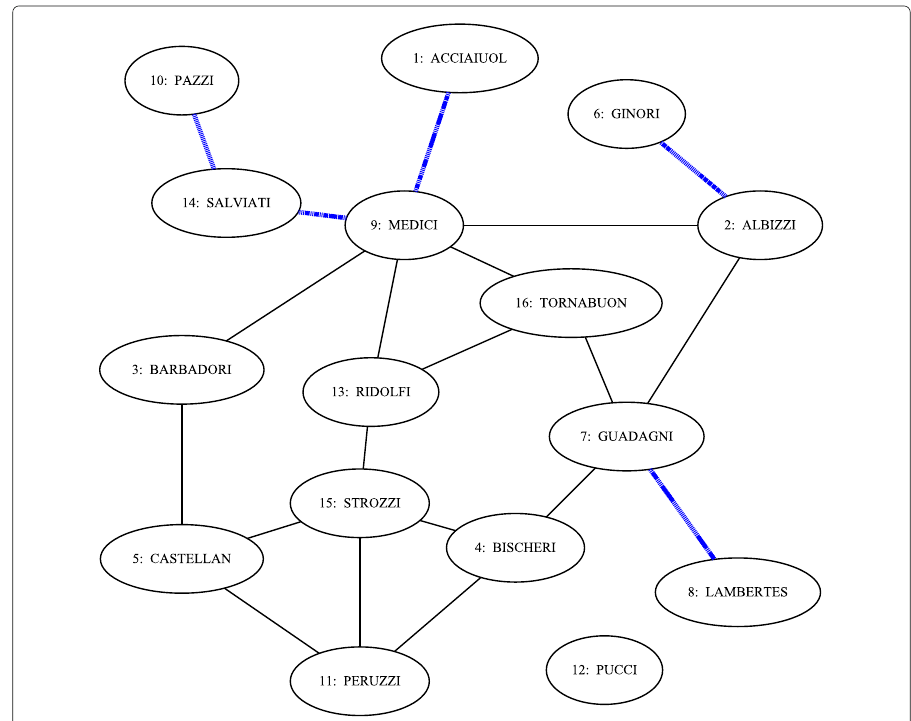
Fig. 13 Network model of the Florentine families of the Italian Renaissance